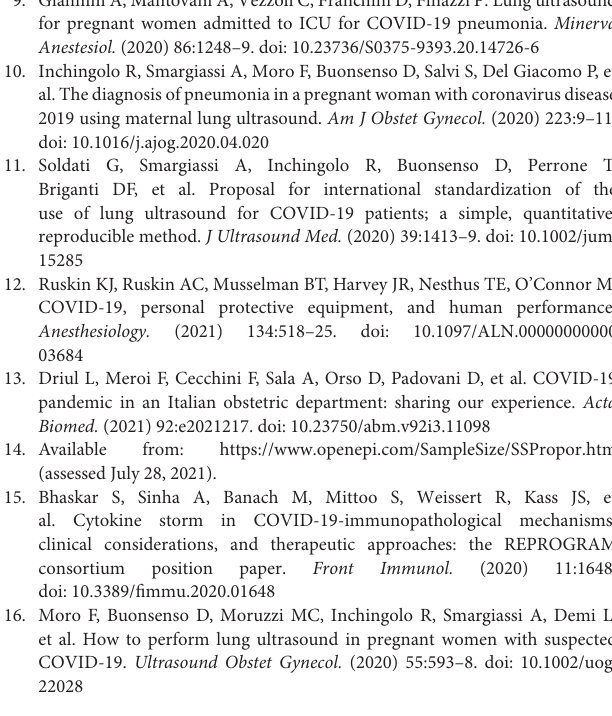
Supplementary Figure S1 | “Light beam” ultrasound finding at the base of a pregnant woman of 29 weeks of gestation. Supplementary Figure S2 | Linear regression between LUS score and some COVID-19 biomarkers. Counterclockwise, from top to bottom: (A) positive correlation between LUS score and body temperature (Adj R 2 = 0.23; p = 0.004); (B) positive correlation between LUS score and aPTT (Adj R 2 = 0.19; p = 0.006); (C) positive correlation between LUS score and D-dimer (Adj R 2 = 0.22; p = 0.004); (D) positive correlation between LUS score and Length-of-stay (Adj R 2 = 0.38; p < 0.001); (E) positive correlation between LUS score and interleukin-6 (Adj R 2 = 0.14; p = 0.013); (F) positive correlation between LUS score and C reactive protein (Adj R 2 = 0.14; p = 0.011); (G) positive correlation between LUS score and pro-adrenomedullina (Adj R 2 = 0.12; p = 0.02); (H) inverse correlation between LUS score and arterial oxygen saturation (Adj R 2 = 0.18; p = 0.004). LUS, lung